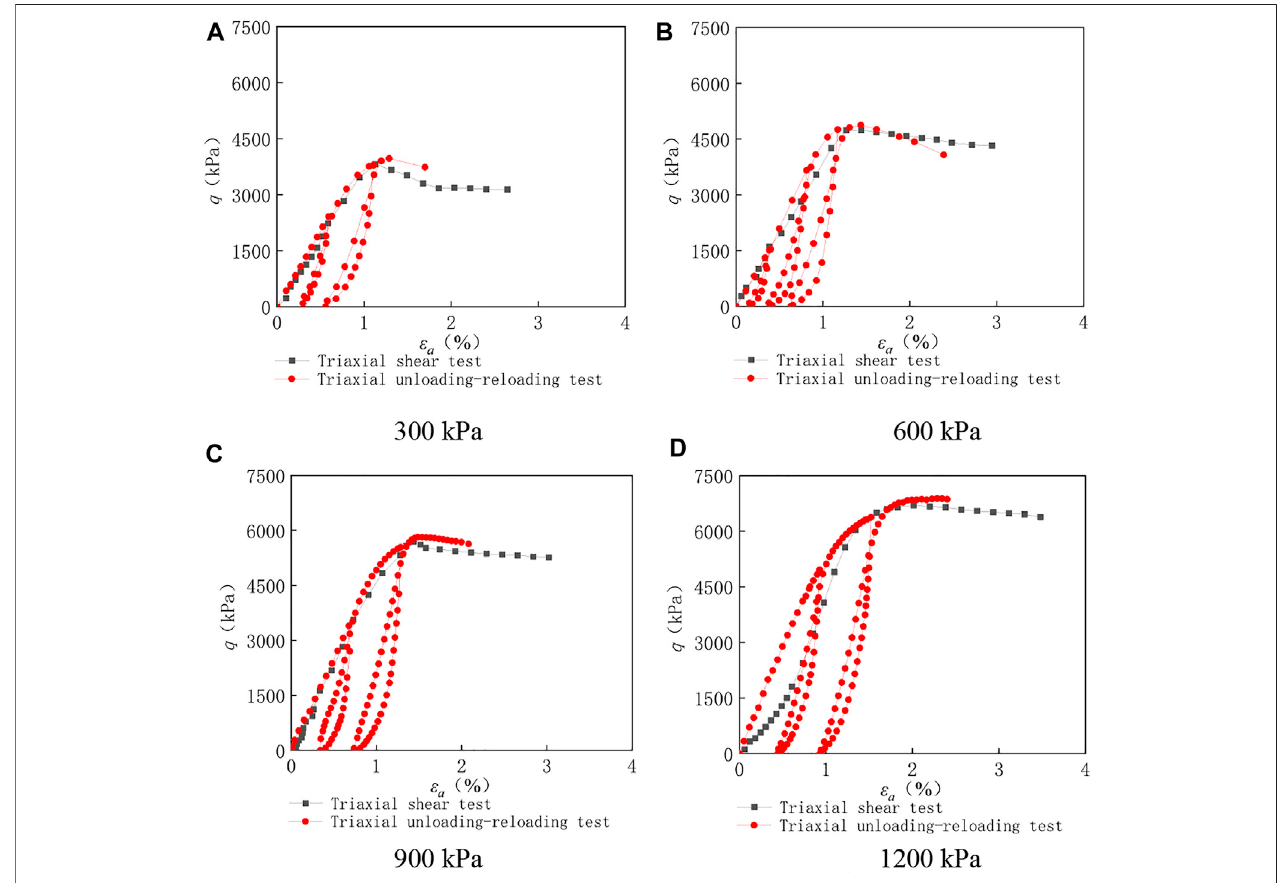
FIGURE 3 | Stress – strain curves of LCSG material with cemented content of 60 kg/m 3 under different con fi ning pressures. (A) 300 kPa (B) 600 kPa (C) 900 kPa (D) 1,200 kPa.